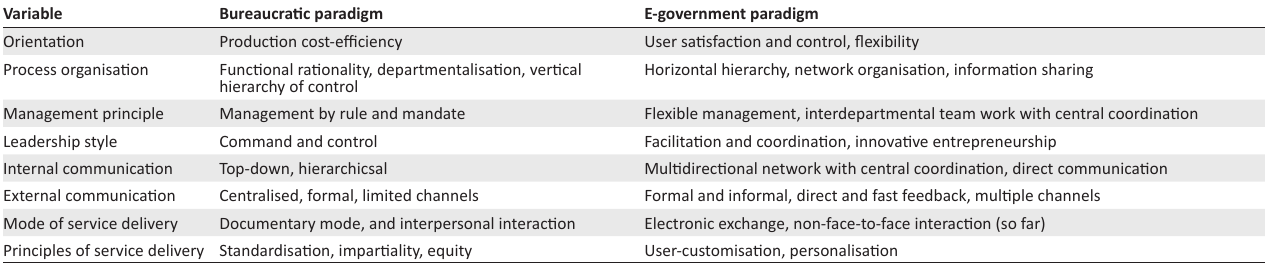
TABLE 1: Shifting paradigms in public service